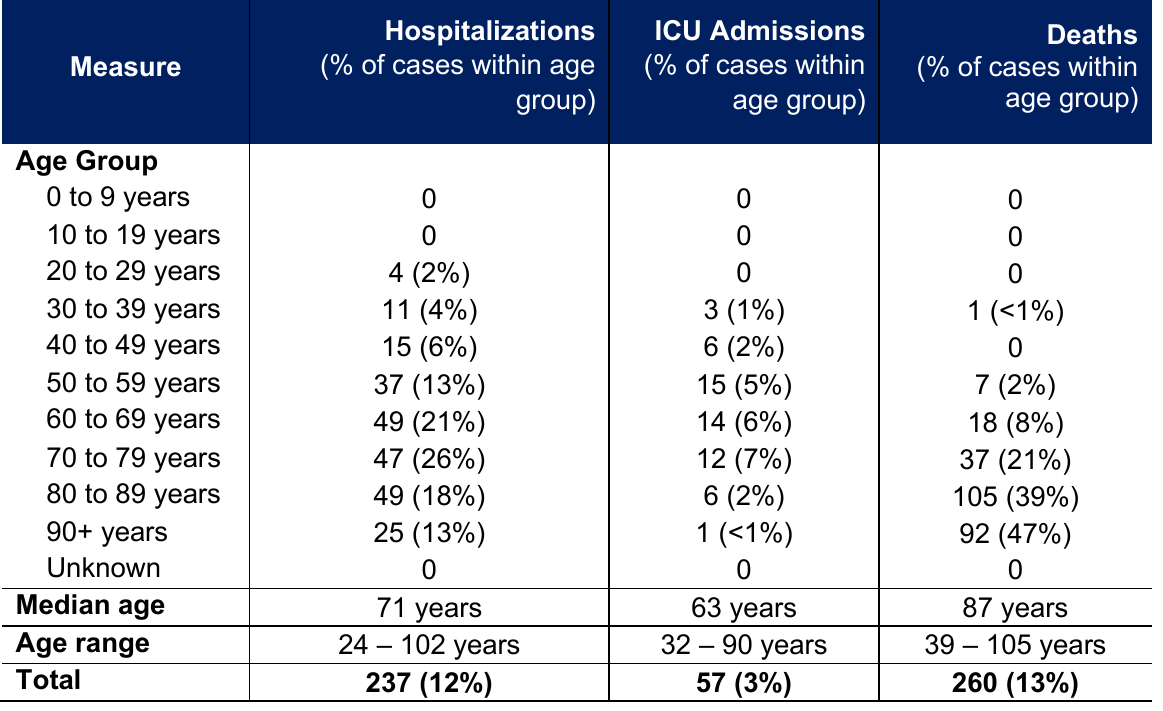
Table 2. Age of Ottawa residents with confirmed COVID-19 that have been hospitalized (cumulative) and in intensive care (cumulative) (n=2,036)